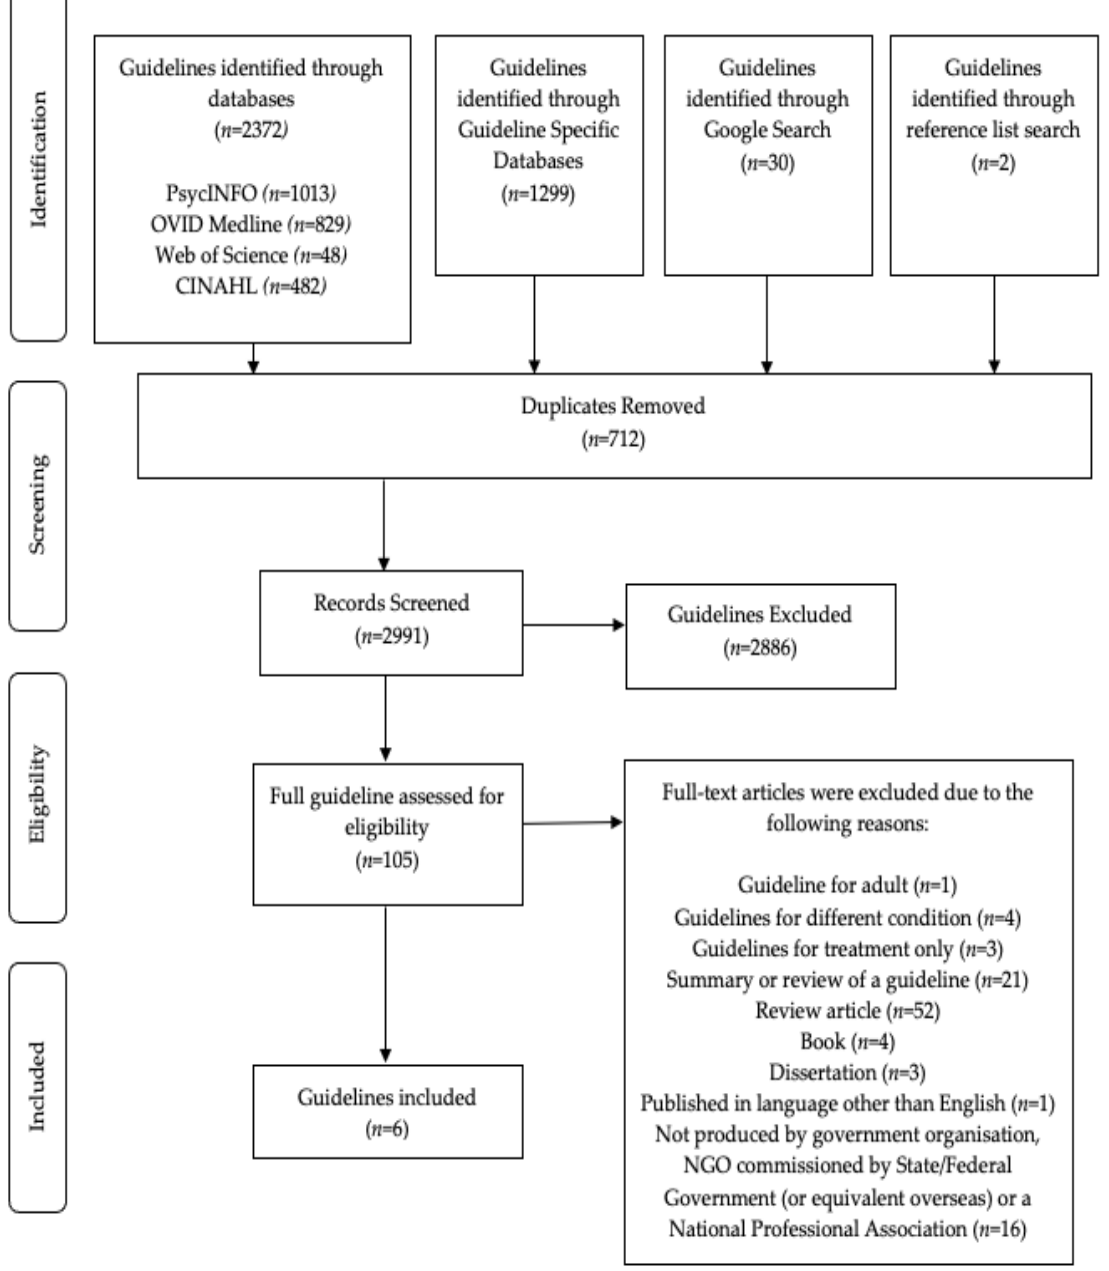
Figure 1. PRISMA flowchart for the study selection process.